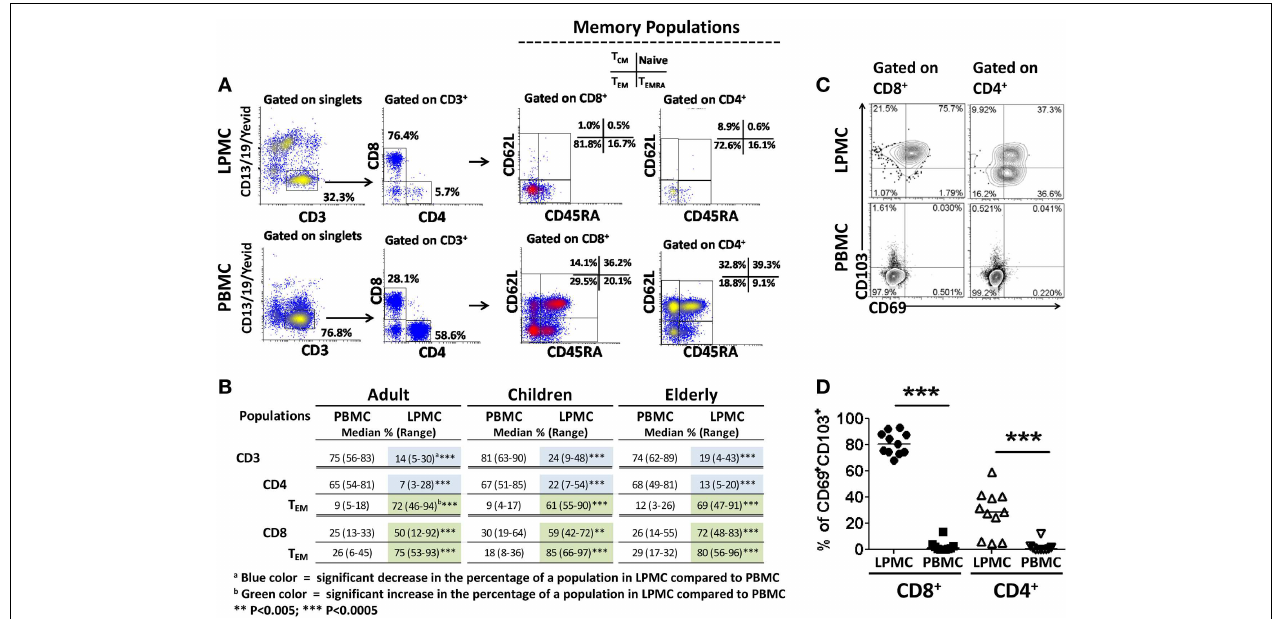
populations in gastric LPMC and PBMC from all three age groups. (C) Identification of tissue-resident memoryT (T RM ) cells in gastric LPMC. Representative plots showing expression ofT RM cells as defined by the concomitant expression of CD103 and CD69 markers on CD8 + and CD4 + T cells in gastric LPMC and PBMC. (D) Cumulative data ( n = 10) showing the percentage of gastricT RM cells among CD8 + and CD4 + T cells from LPMC and PBMC (*** p <